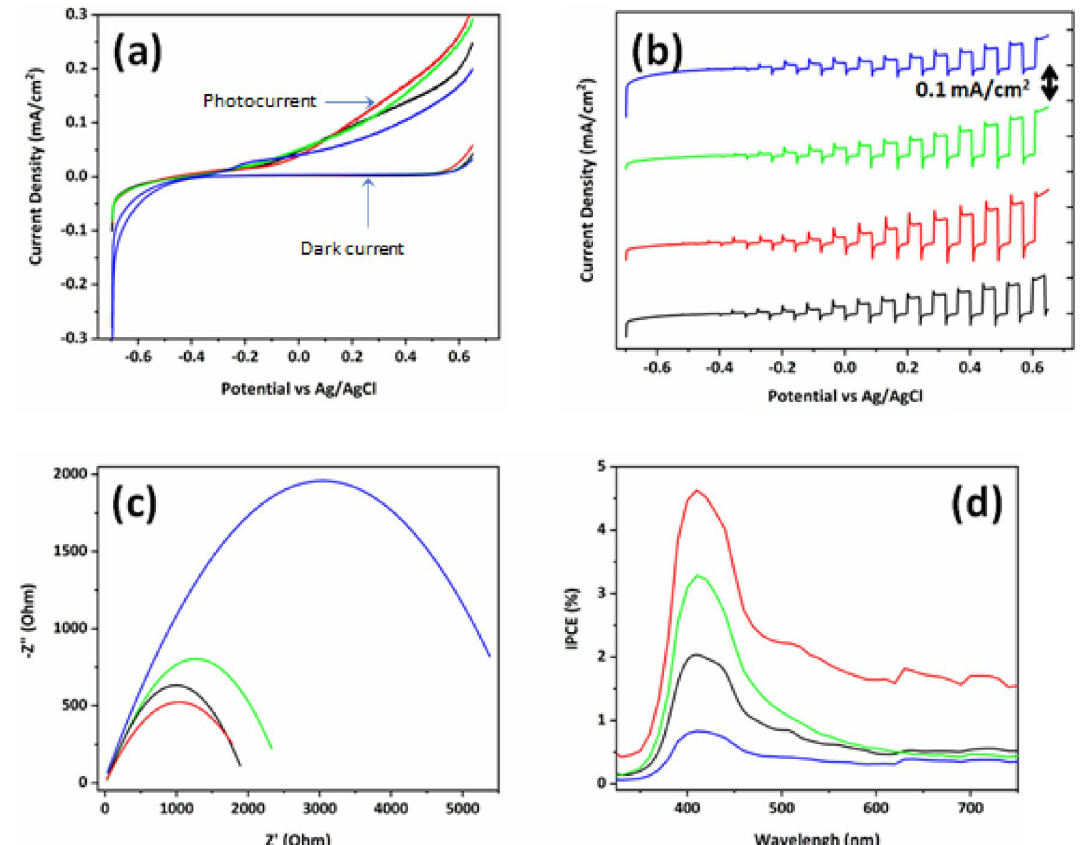
Figure 6. Photoelectrochemical performances of Cu 2+ ion doped hematite thin film with pristine (black), 1 mol% (red), 3 mol% (green), and 5 mol% (blue). ( a ) LSV measurement, ( b ) chopped photocurrent measurement, ( c ) electrochemical impedance spectroscopy spectra and ( d ) IPCE of Cu 2+ ion doped hematite thin